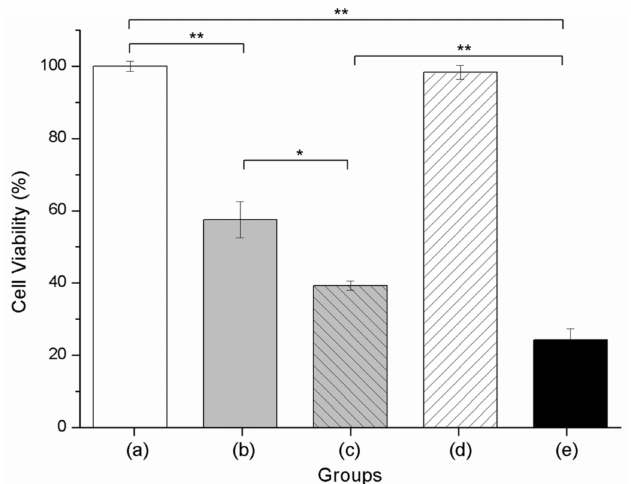
Figure 9. In vitro therapeutic activity of OVCAR-3 cells treated with different formulations: ( a ) control (cell only), ( b ) free Dox, ( c ) NOCC/Dox/HA-SH, ( d ) SH-HA-Dopa-CaP/siBcl-2, and ( e ) Dox/siBcl-2 chimeric NPs for 48 h of co-incubation. Data are show as mean ± SD (n = 3). * p < 0.01, ** p <